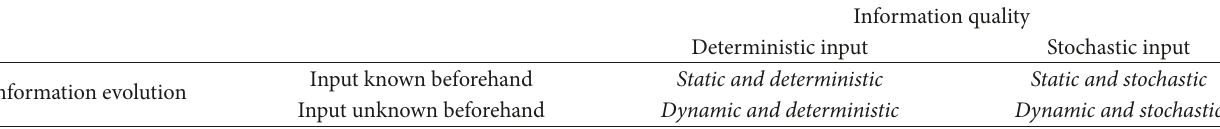
Table 1: Taxonomy of vehicle routing problems by information evolution and